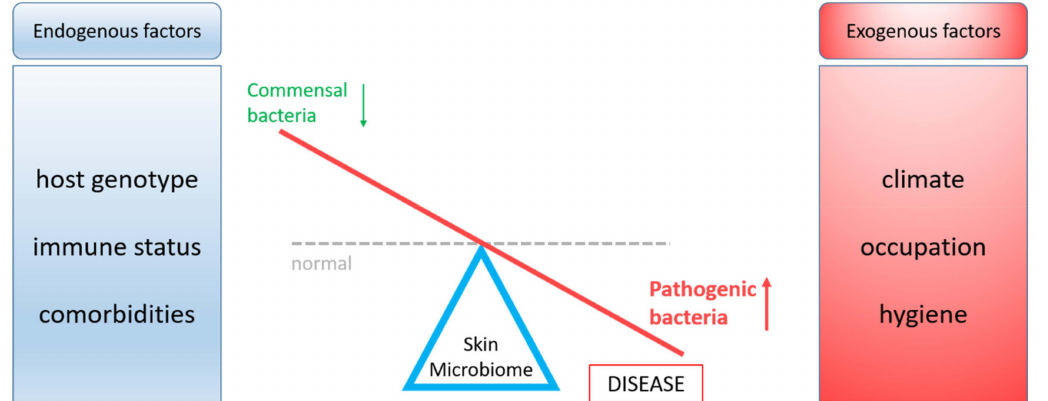
Figure 1. Impact of endogenous and exogenous factors on the skin microbiome dashed line, normal (balanced) microbiota; red line, microbiota in